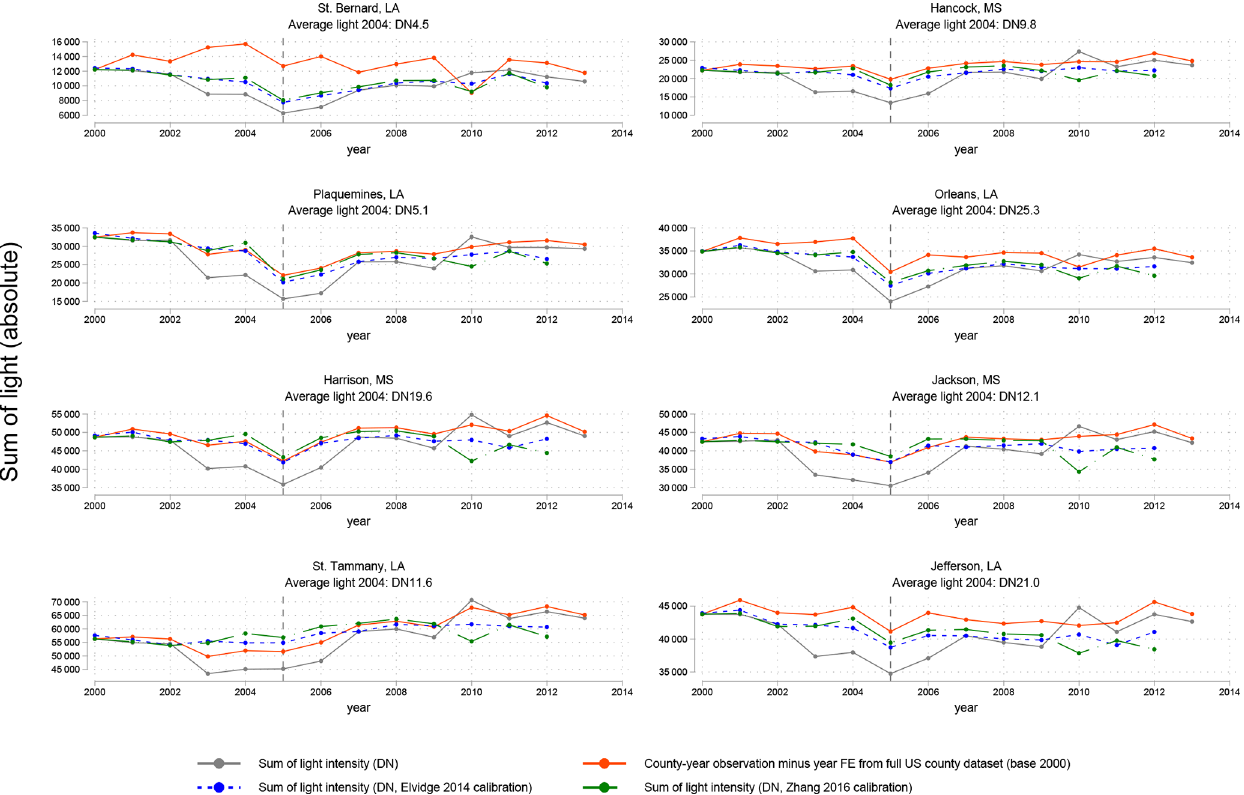
Figure B1. Corrected night light data (absolute sum of light). Four series: raw data (gray), fixed-effect adjustment, invariant area calibration (Elvidge et al., 2014), and global consistent bias calibration (Zhang et al.,